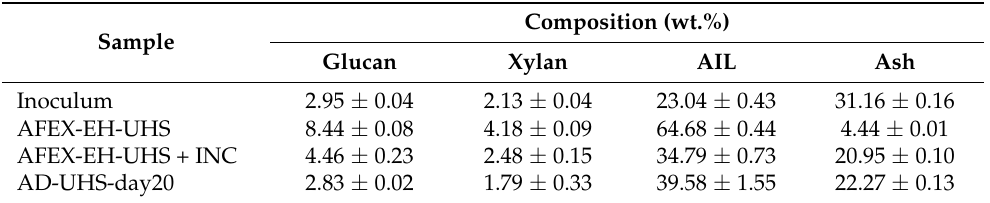
Table 1. Composition of the inoculum, AFEX-EH-UHS, and